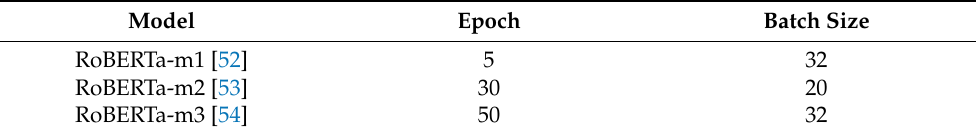
Table 1. RoBERTa model parameter settings for